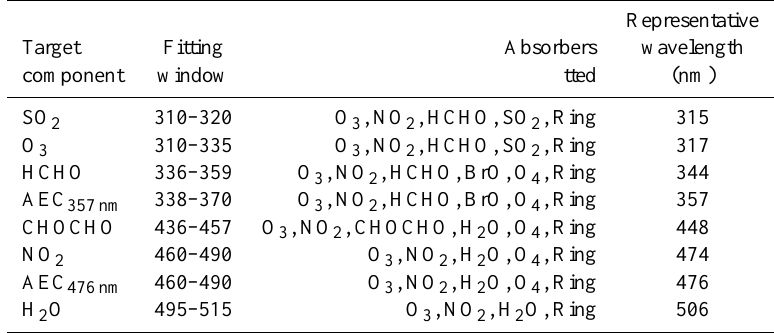
Table 1. Fitting windows and absorbers fitted in DOAS analysis. The representative wavelength for each target component is its cross- section-weighted mean wavelength over the fitting